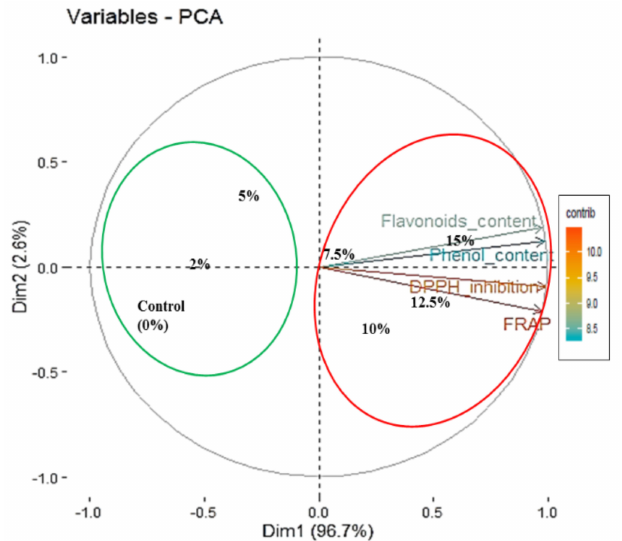
Figure 6. Results of PCA of data on the effect of supplementation of pasta with different concentrations of Spirulina biomass (%) on antioxidant and functional properties/parameters presented as scatter